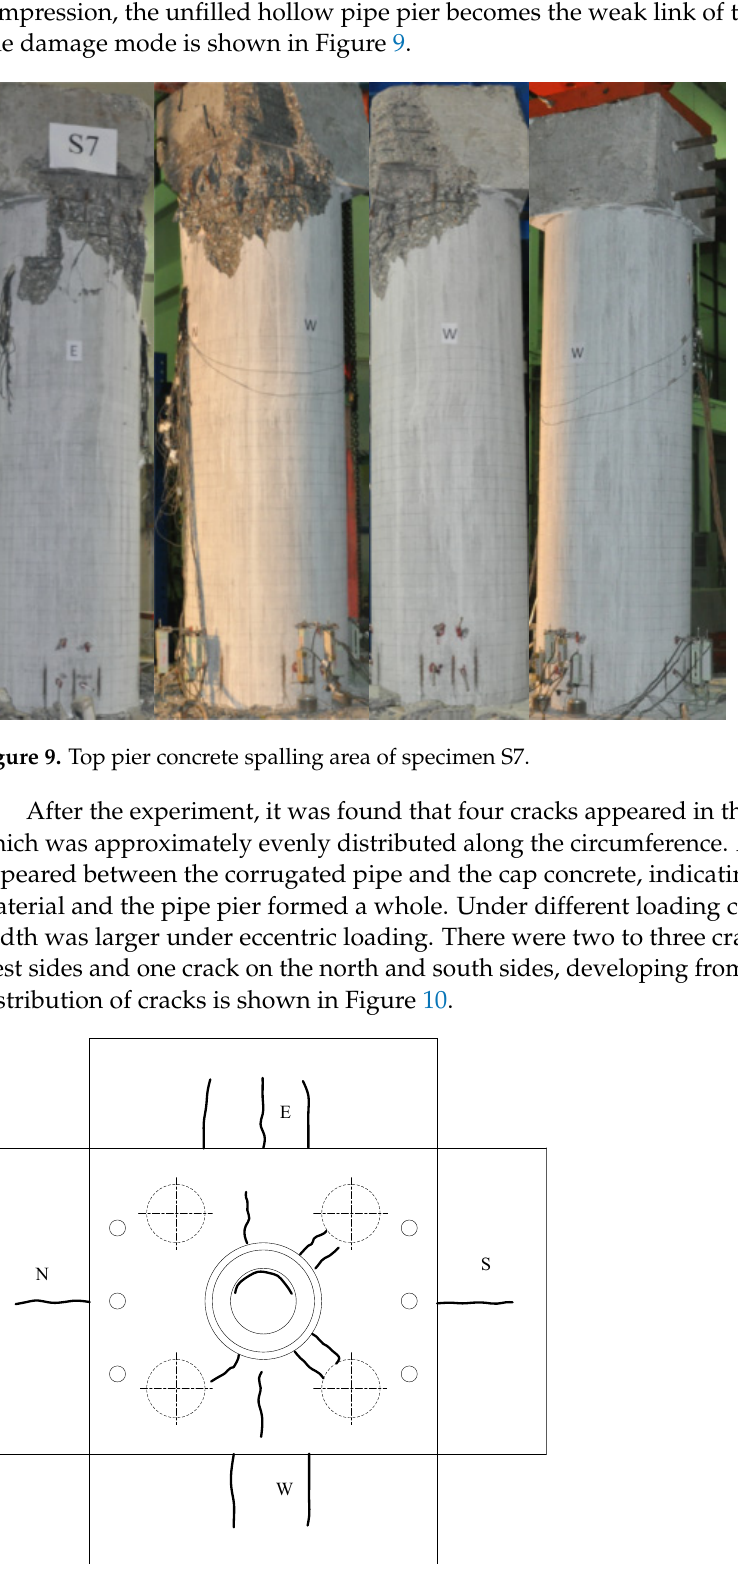
Figure 10. The distribution of cracks on the bottom and side of the cap.